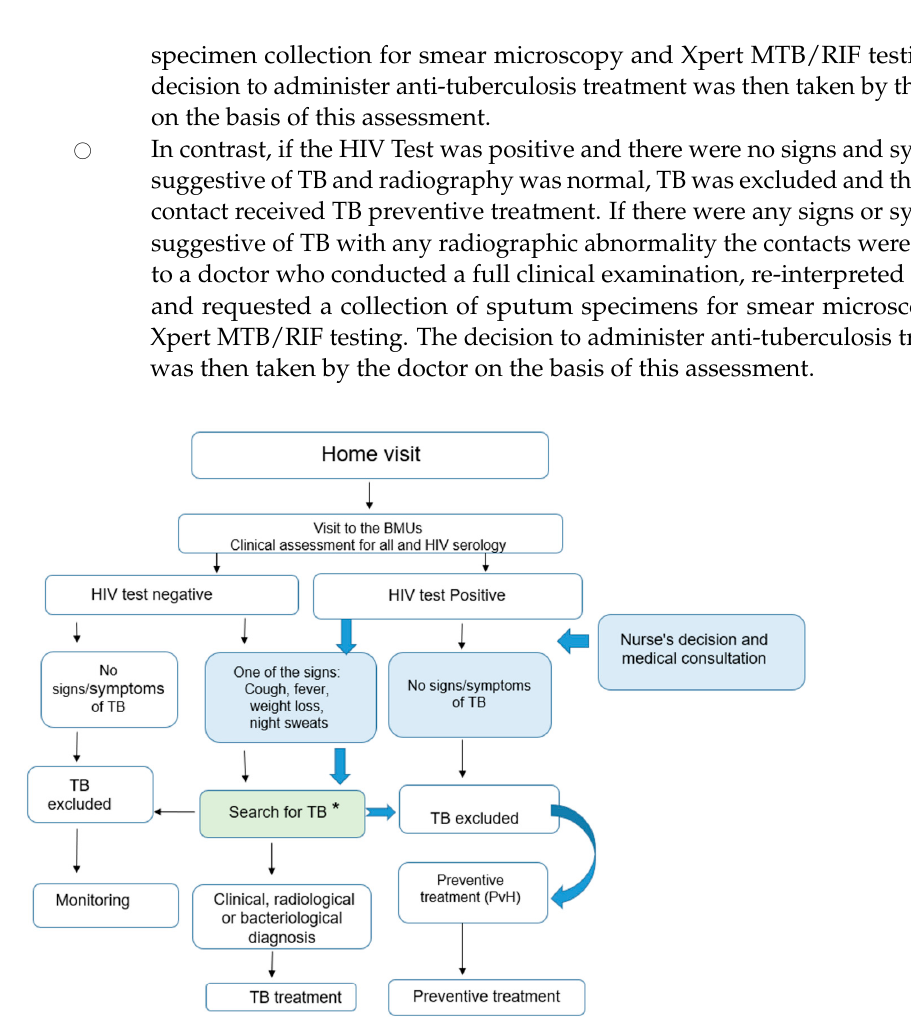
Figure 3. Screening algorithm used for adults and adolescents. * the following additional tests: (1) Chest X-Ray; (2) Sputum specimens for Smear and/or Xpert MTB/RIF depending on the